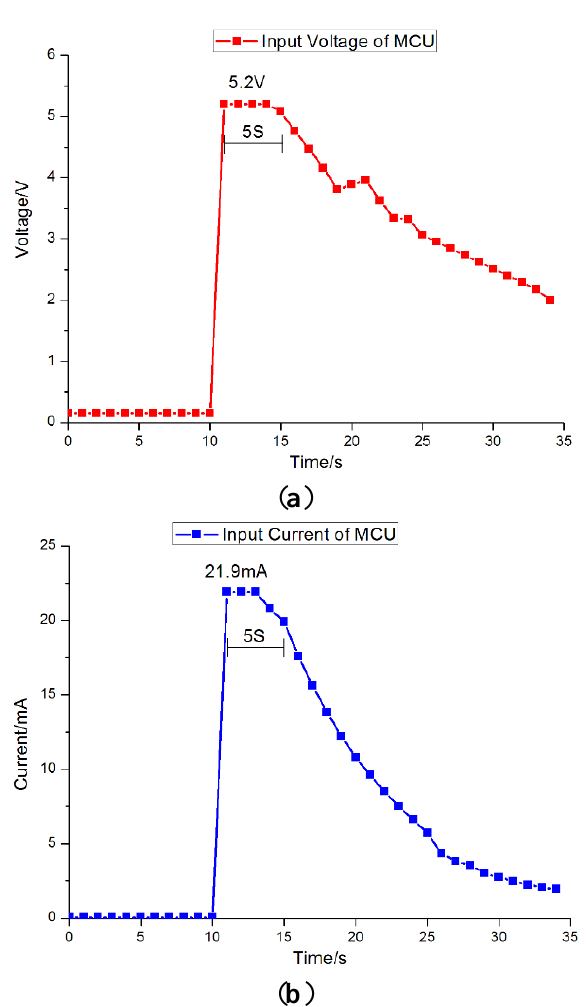
Figure 14. Voltage and current inputting the MCU. ( a ) Voltage inputting the MCU; ( b ) Current inputting the MCU.